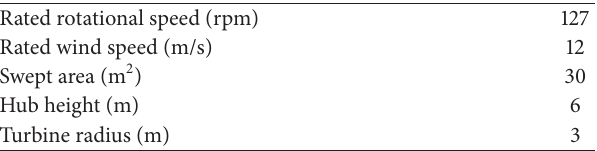
Table 1: Turbine parameters.